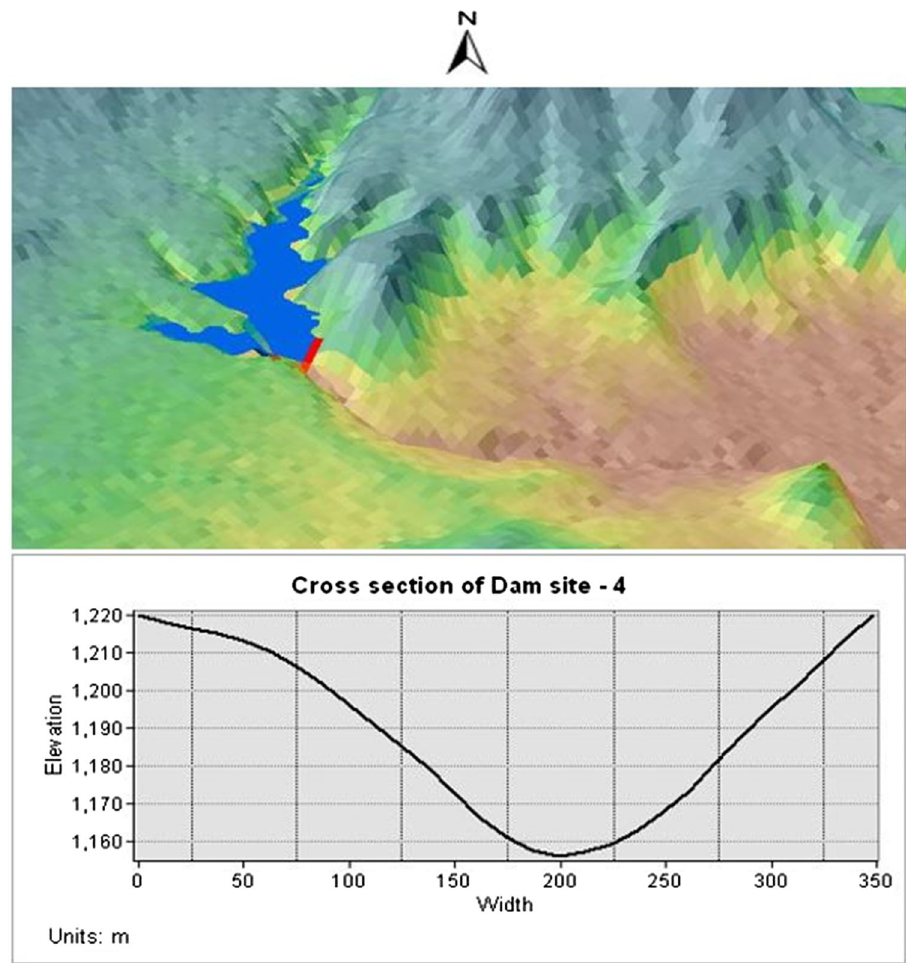
Fig. 19 3D view and cross sec- tion of proposed dam